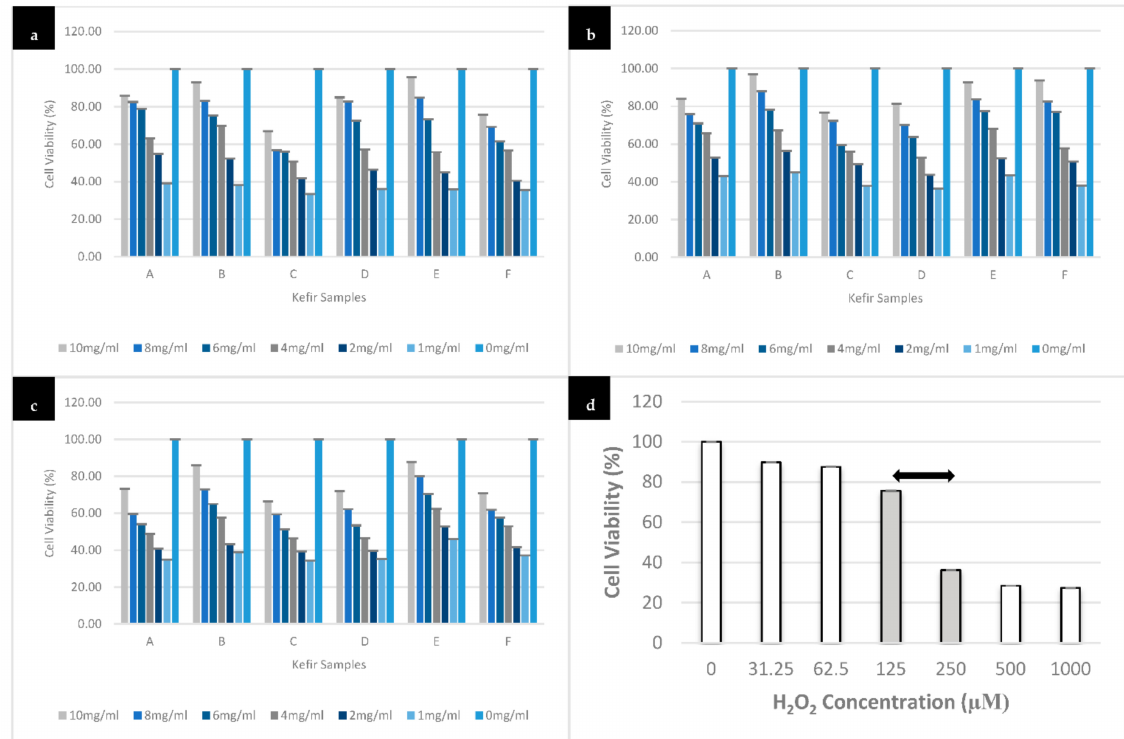
Figure 3. Concentration-dependent viability of the differentiated SH-SY5Y cells pre-treated with kefir water samples (1 to 10 mg/mL). ( a ) Display 24 h, ( b ) 48 h, and ( c ) 72 h plus 24 h of 190 µ M H 2 O 2 exposure, whereas ( d ) is an H 2 O 2 -induced (31.25 to 1000) µ M cytotoxic analysis used in this study with IC50 = 190 µ M at 24 h. The experiment was carried out in triplicates and values are presented in means ±